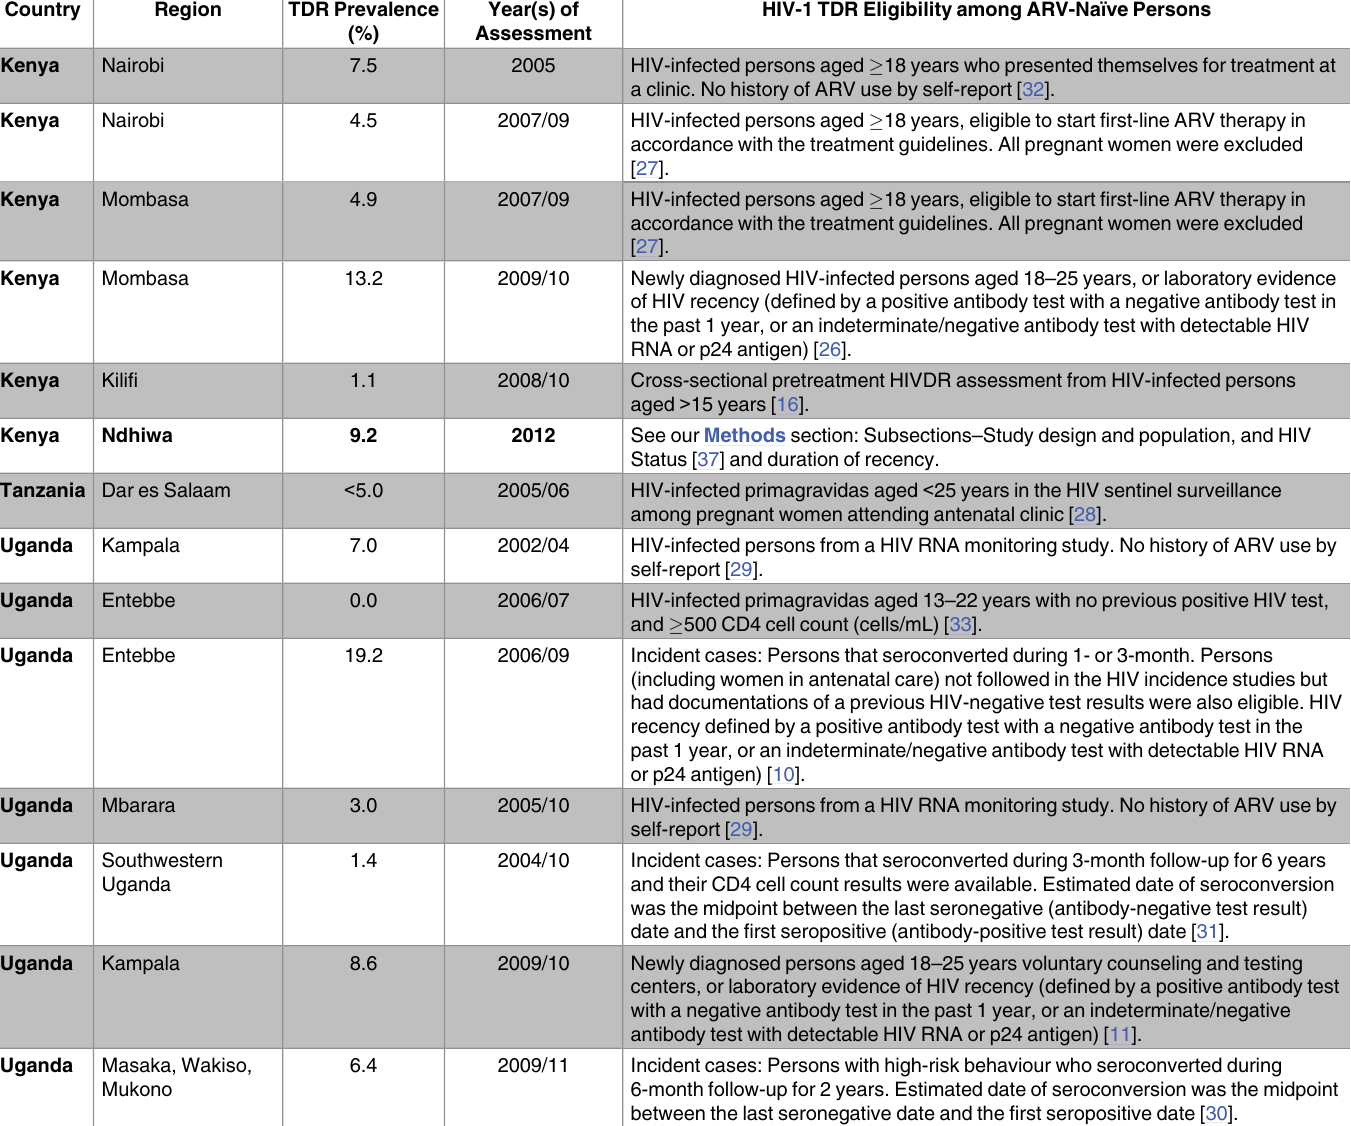
Table 2. Prevalence of TDR in selected regions of East Africa.